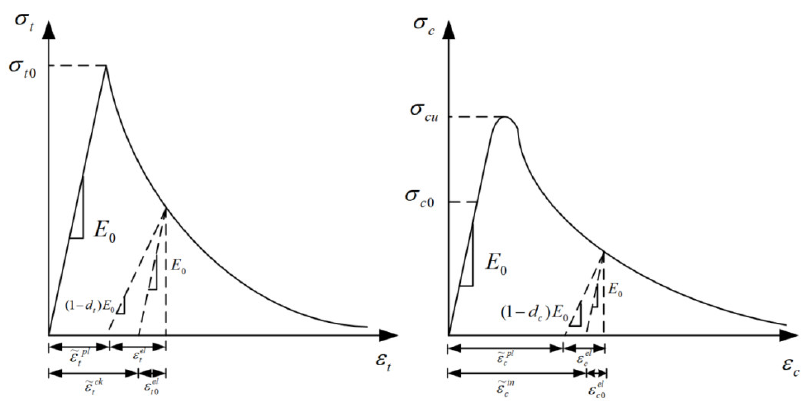
Figure 3. Uniaxial tensile/compressive stress–strain curve of concrete. Under a uniaxial tensile load, the peak stress of concrete is 0 t . As damage to the material occurred, the tensile stress–strain curve of concrete steps into the softening stage.